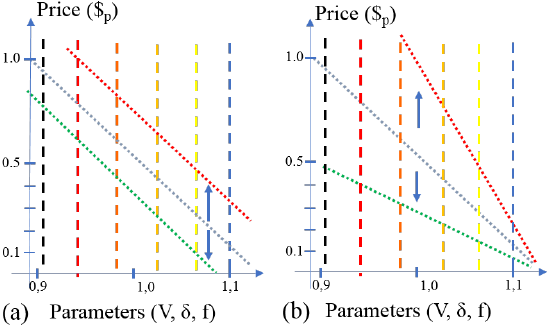
Figure 9. Relationship between bus measurements and prices. ( a ) Vertical offset. ( b ) Different slope.